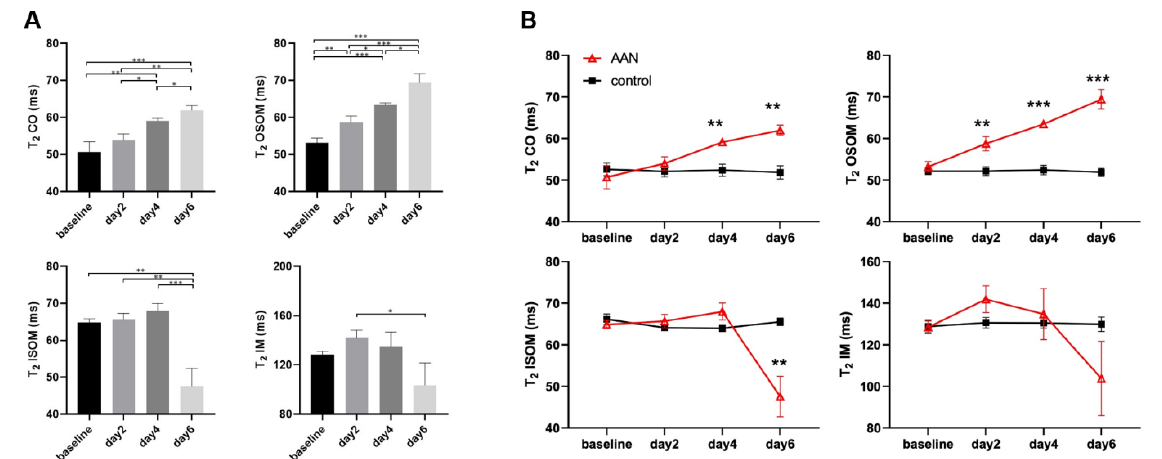
Figure 4. Statistical analysis of T2 relaxation times for the AAN group ( A ) and the control group ( B ). *** p < 0.001, ** p < 0.01, * p < 0.05. CO, cortex; OSOM, outer stripe of outer medulla; ISOM, inner stripe of outer medulla; IM, inner medulla.